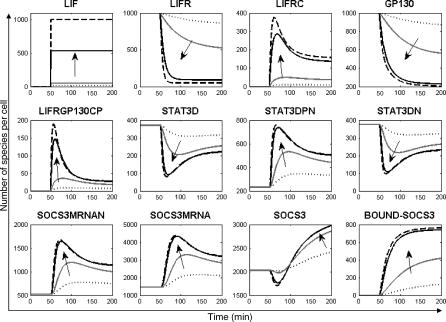
Computational Simulation of Jak/Stat3 Pathway Activation at Different LIF Concentrations Shows Transient KineticsLIF was added in increasing concentrations of 10, 50, 500, and 1,000 pM in the direction of arrow. LIFRC is the complex of LIFR with LIF, LIFRGP130CP is the phosphorylated heterodimeric complex of LIFR and GP130, STAT3DPN is nuclear Tyr705 phosphorylated Stat3, STAT3DN is nuclear Stat3, SOCS3MRNAN and SOCS3MRNA are the nuclear and cytoplasmic levels of SOCS3 mRNA, and BOUND-SOCS3 is the total number of receptor complexes which are bound to SOCS3. This representative simulation was run for 200 min, and the number of activated proteins per cell are plotted as a function of time.